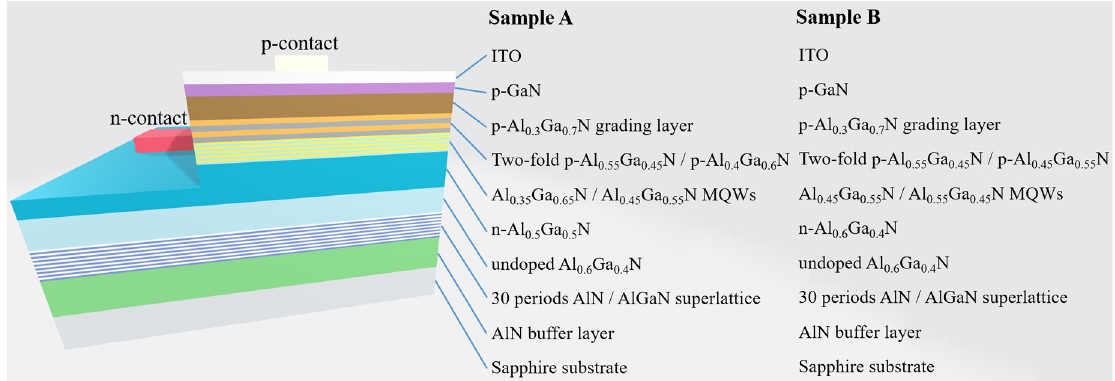
Figure 1. Schematic representation of the epitaxial structures of samples A and